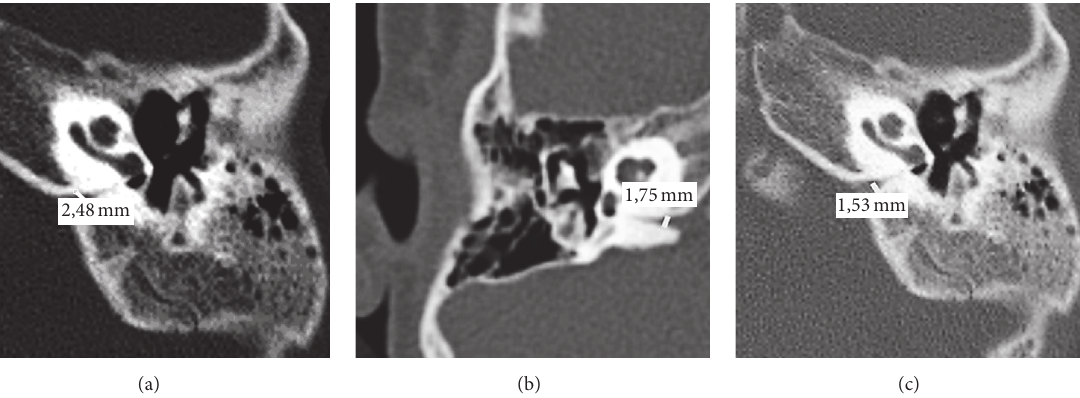
Figure 2: Enlarged cochlear aqueduct.